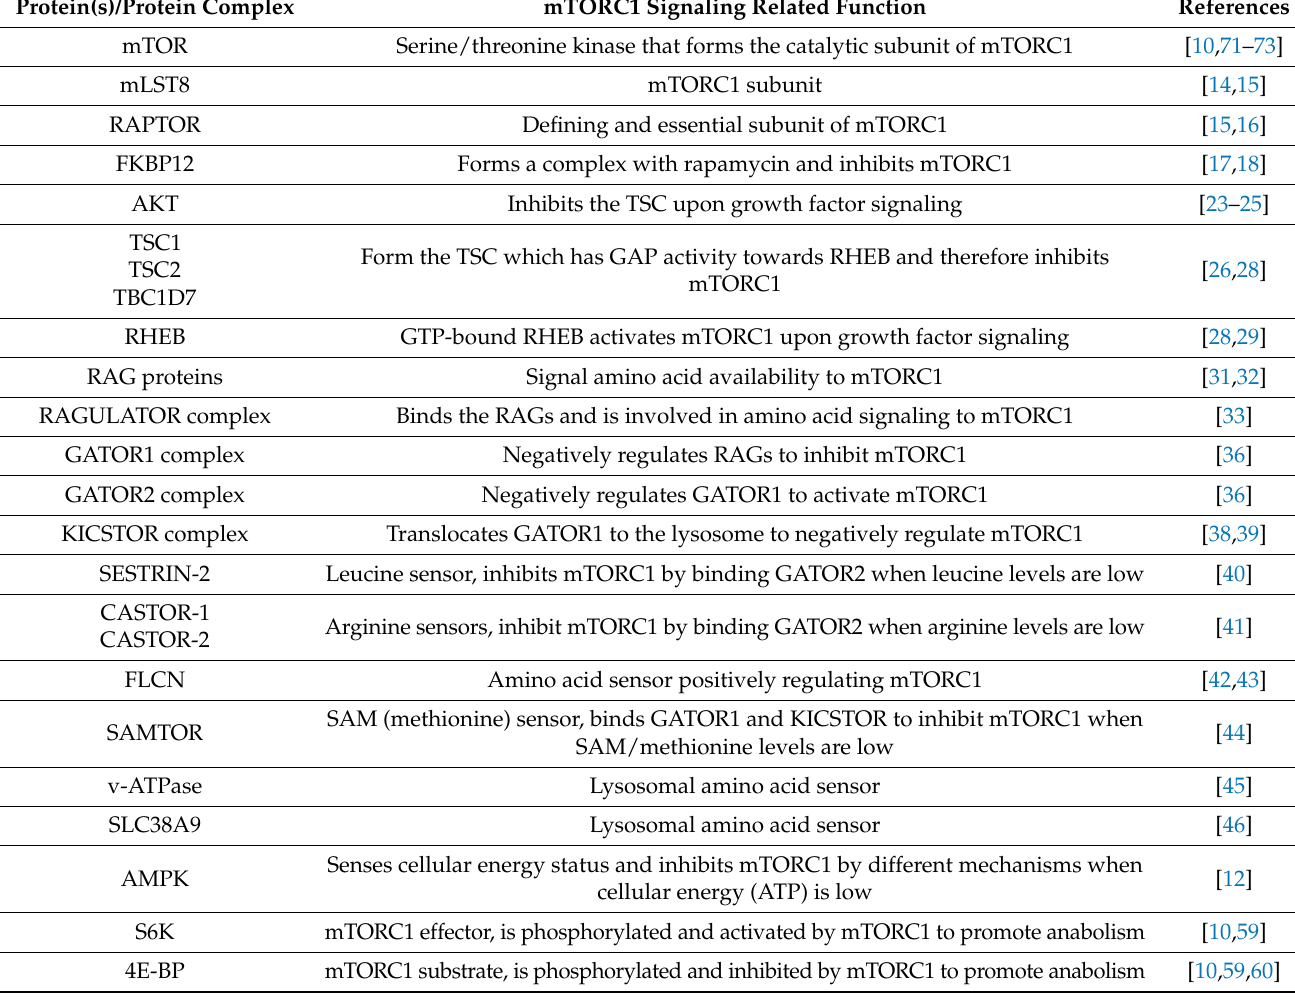
Table 1. Overview of major mTORC1 signaling components discussed in the text and their corresponding functions. Protein(s)/Protein Complex mTORC1 Signaling Related